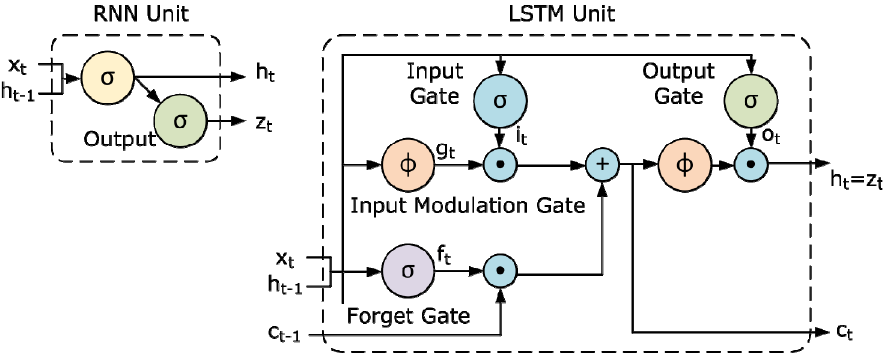
Figure 5. The RNN unit consists of one hidden layer and the output. The LSTM unit comprises a more complex architecture in order to determine which data will be used in each time